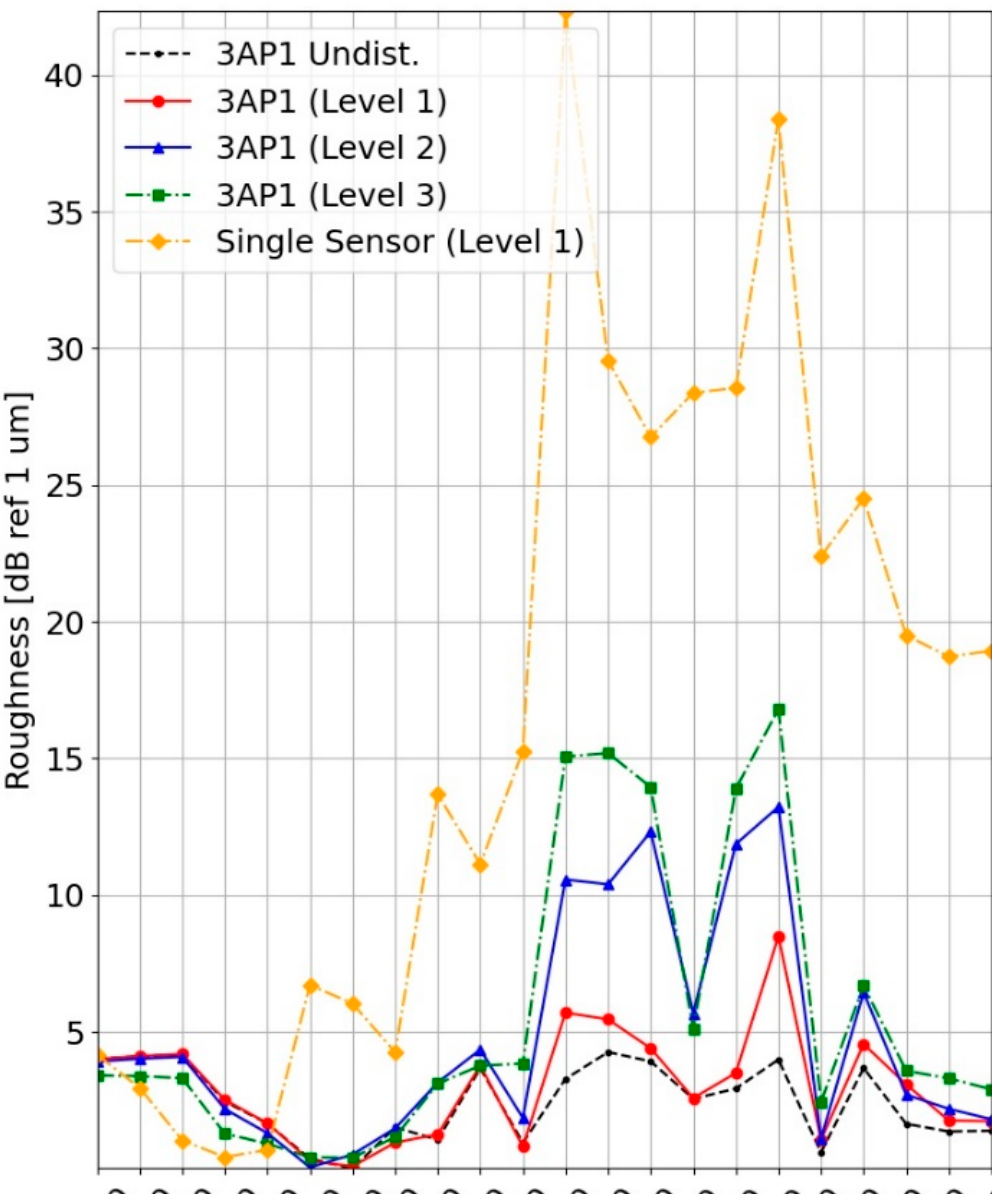
Figure 7. Absolute error of acoustic roughness for measurements with sensor plate displacements (amplitude indicated as levels).